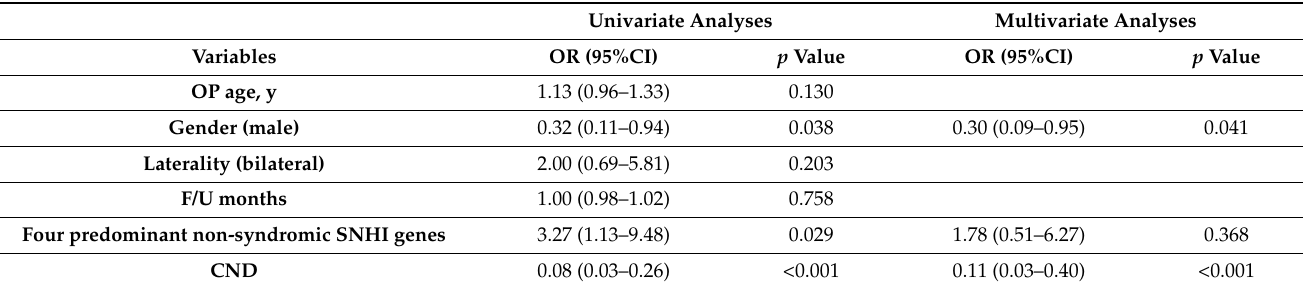
Table 5. Logistic regression analyses of different variables on the CI